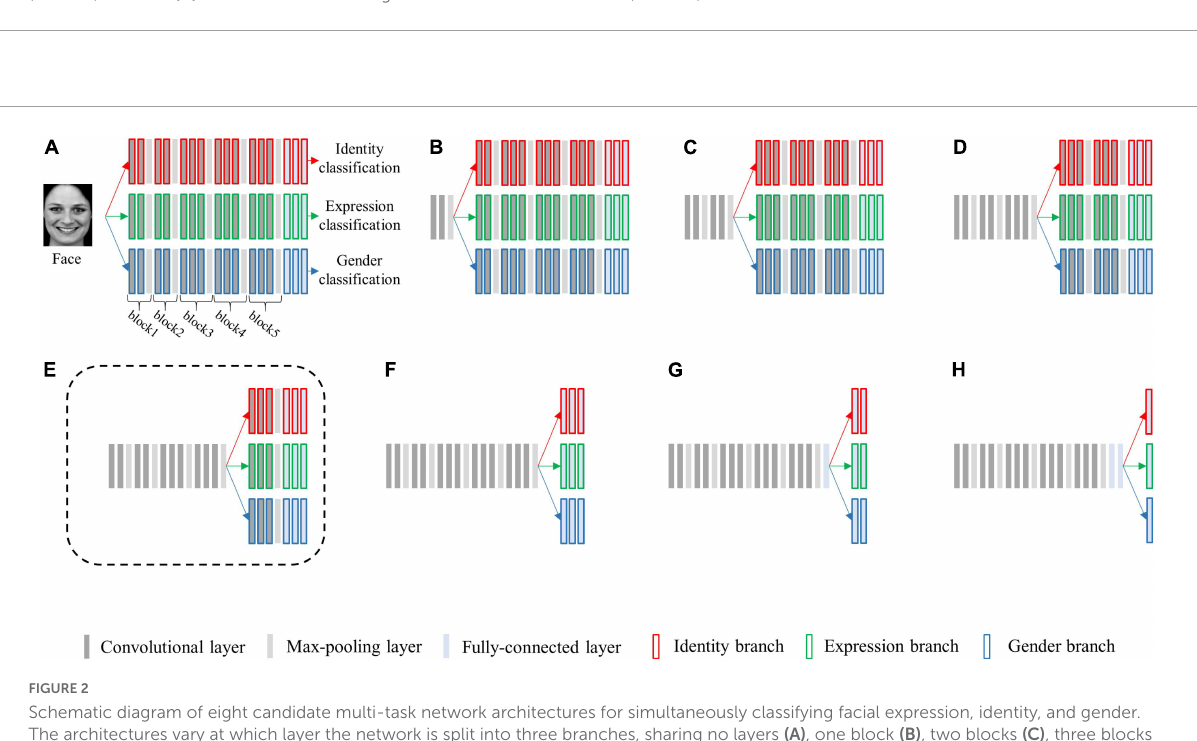
FIGURE1 Schematic illustration of the perceived face reconstruction framework. (A) Algorithmic workflow. (B) The multi-task deep learning network (MTDLN) module. (C) The multi-conditional generative adversarial network (mcGAN) module.